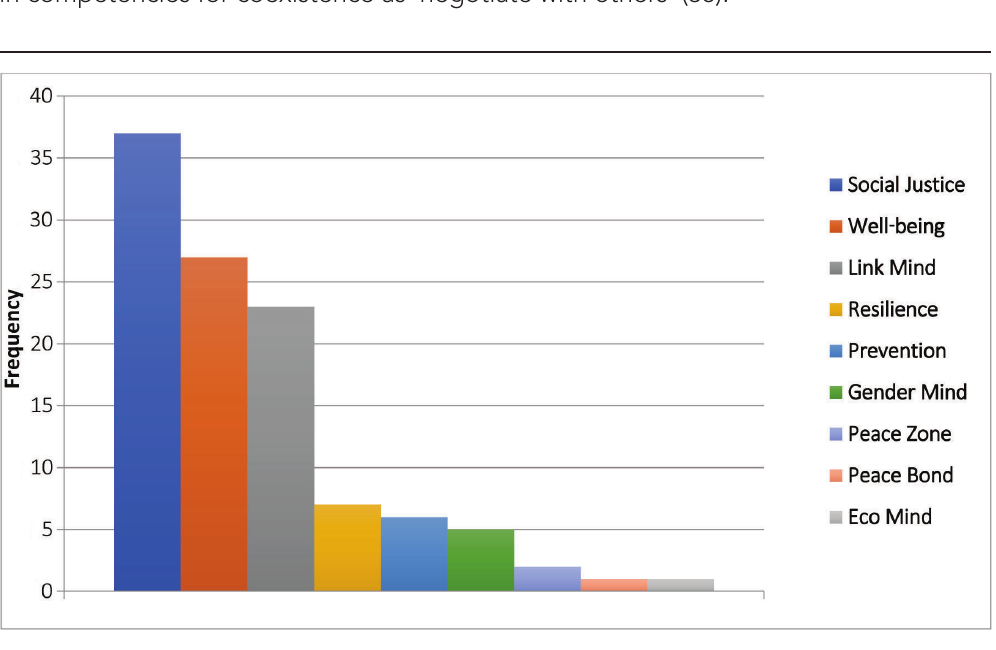
Figure 4: Element Three – Positive peace elements in Plan de Estudios (2011) All facets of positive peace are mentioned in the Plan de Estudios, although with varying levels of explanation and perceived importance. The most common element is social justice (N=37), followed by well-being (N=27), link mind (N=23), resilience (N=7), prevention (N=6), gender mind (N=5), peace zone (N=2), eco mind (N=1) and peace bond (N=1), and PECA positive peace nodes congruent with the SDGs include social justice, well-being, gender mind, eco mind and